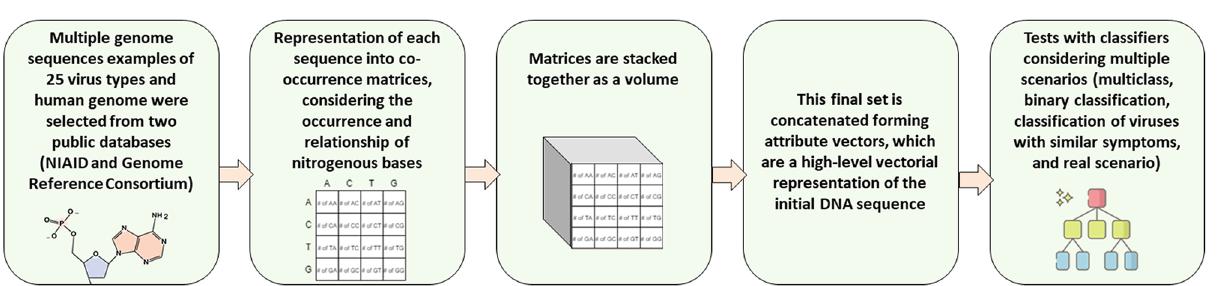
Figure 1. General scheme of the proposal: the RT-PCR process converts and amplify the virus RNA obtained from collected samples and returns a textual DNA sequence as a text file. This textual DNA sequence is converted into a numeric vector by the pseudo-convolutional representation process and then classified into healthy human tissue or one of the 25 virus families or SARS-CoV-2 species by a determined learning machine. The analysis software then returns the diagnostic decision: if the input sample corresponds to a healthy human sample or a determined virus. These virus DNA sequences were obtained from the NIAID Virus Pathogen Database and Analysis Resource—ViPR 46 . Human participants were not involved in our research. No demographic data were collected as well.